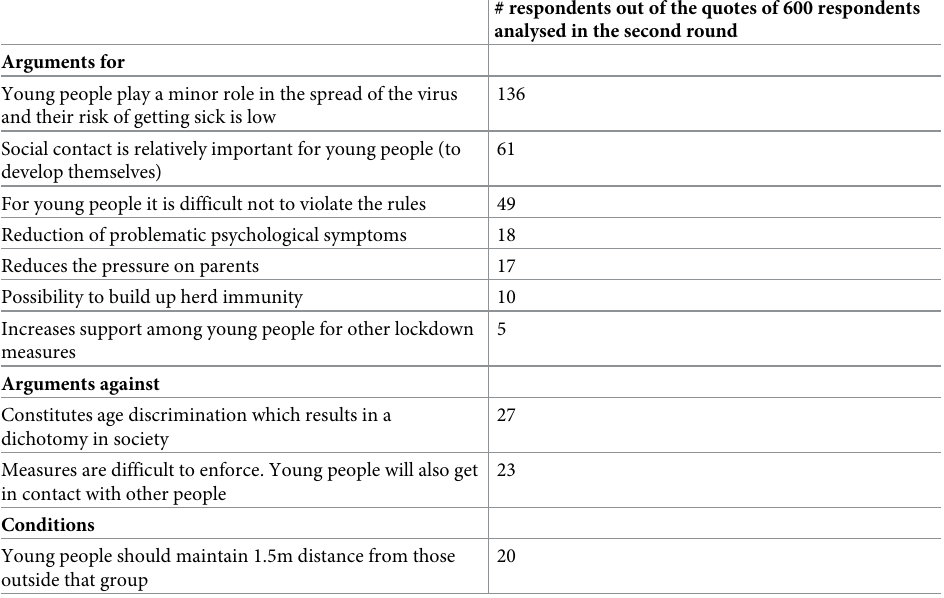
Table 8. Young people may come together again in small groups: Arguments for, arguments against and conditions.